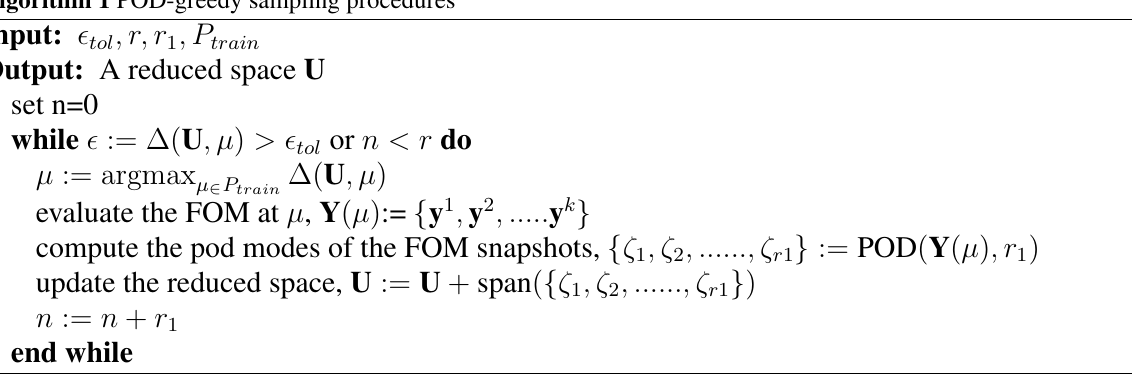
Algorithm 1 POD-greedy sampling